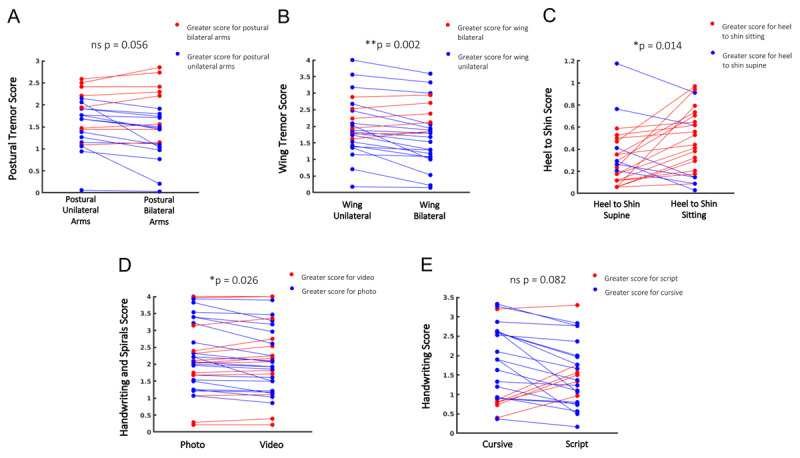
Mean scores (N = 15 raters in A-D and N = 16 raters in E) comparison of individual tremor subjects. Blue shows lower score in second measure, red denotes higher score in second measure. A. Postural tremor done individually vs. done concurrently, B. Wing-Beating tremor done individually vs. done concurrently, C. Heal to shin done while supine vs. while done sitting, D. Combined handwriting and spiral scores when rated only by a photograph vs. when video was also viewed of the subject performing the task, E. Comparison of cursive writing vs. script writing.